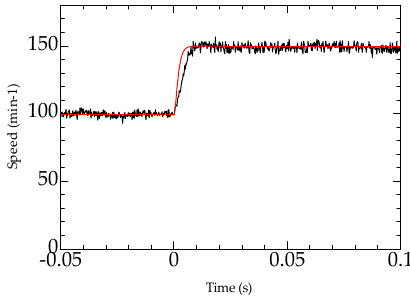
Figure 14. Step response of the tuned PI ‐ P gain controller.